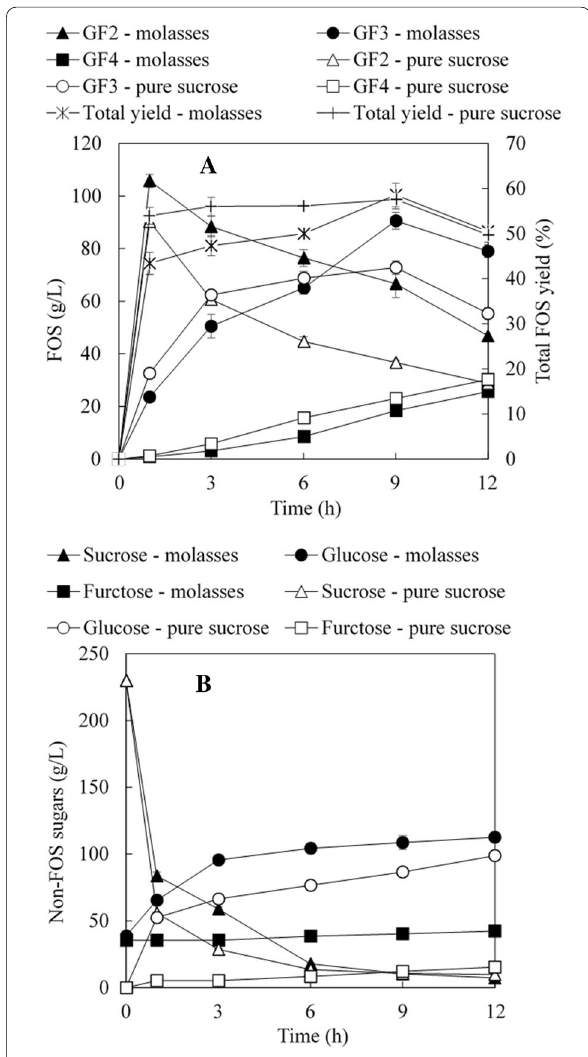
Fig. 4 Kinetics of FOS production using sugarcane molasses and sucrose by A. pullulans cells. A Individual FOS concentration and total FOS yields; B non-FOS sugars